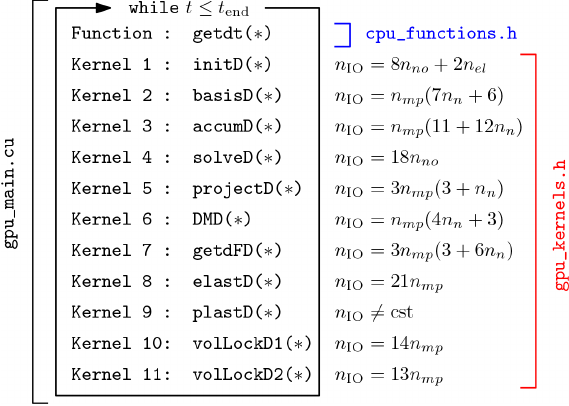
Figure 4. Specific workflow for the source code running of the GPU; t end is a user-defined time that controls the total time of the simulation, and the operator ∗ stands for the pointer object, as in the C language. It should be noted that a vast majority of operations within kernels are performed on